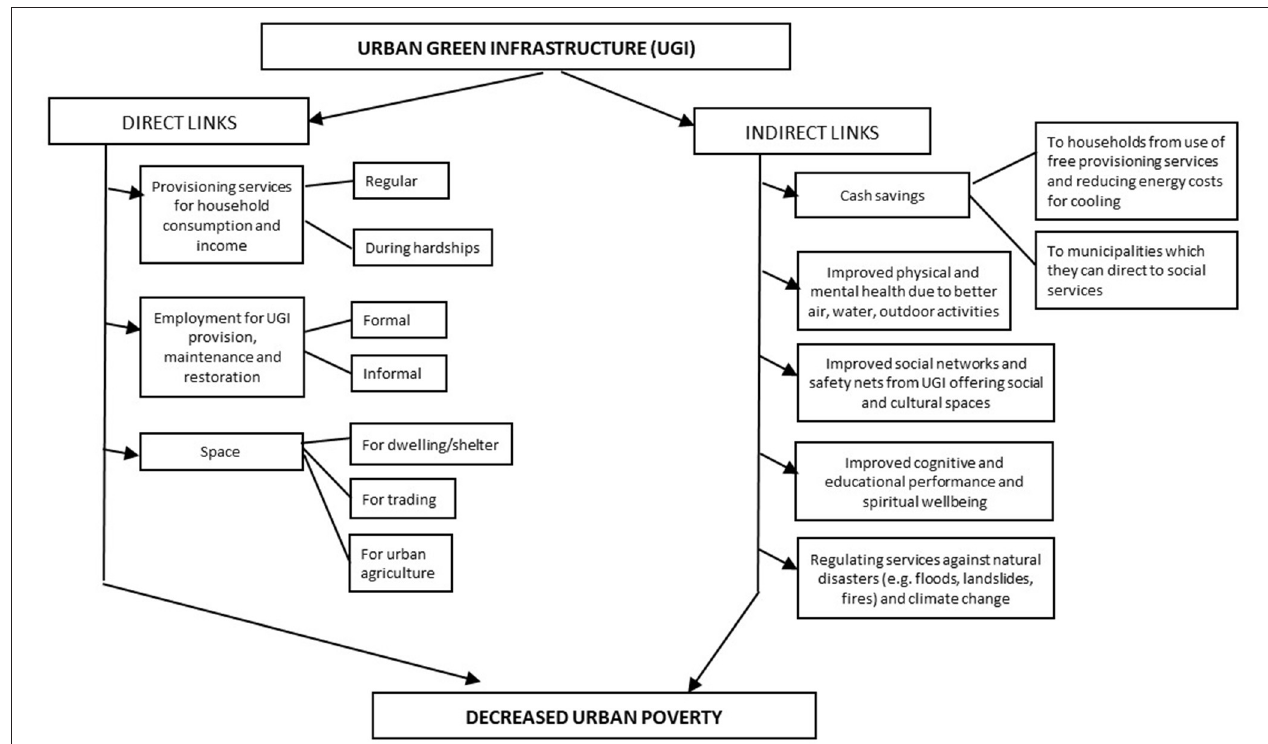
FIGURE 1 | The direct and indirect links through which urban green infrastructure can contribute to the alleviation of urban